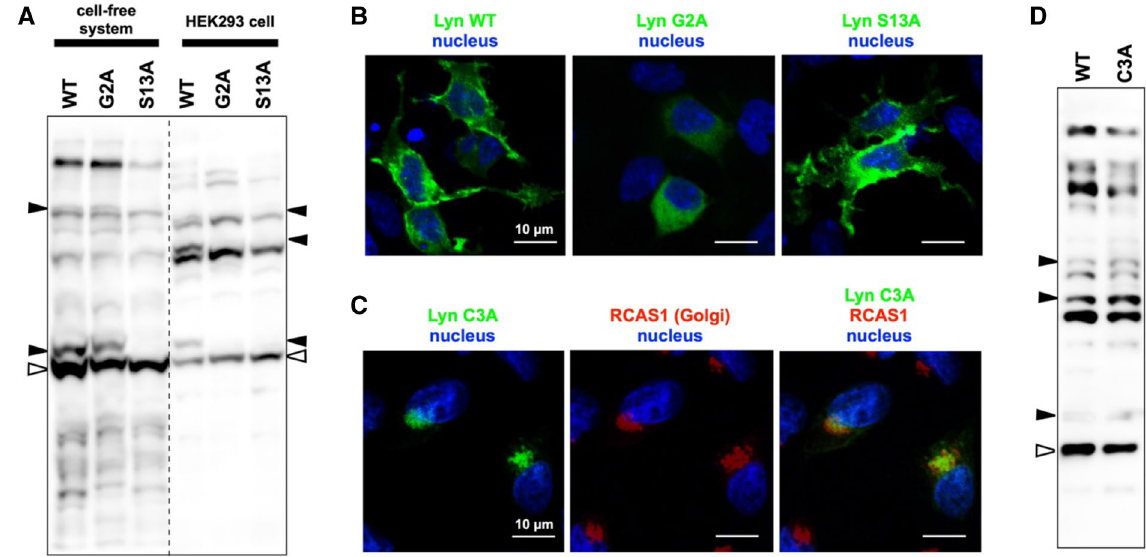
Figure 3. Phos-tag banding image of Lyn synthesized in a cell-free protein-synthesis system, cellular localization of Lyn WT, G2A-, S13A-, and C3A-mutant proteins, and Phos-tag banding image of the WT and C3A-mutant proteins. ( A ) Lyn WT protein, its G2A mutant, and the S13A mutant synthesized by using the TnT T7 Insect Cell Extract Protein Expression System were analyzed by Phos-tag SDS-PAGE (20 μM Zn 2+ –Phos- tag and 7% w/v polyacrylamide). For reference, FLAG-tagged WT and its G2A and S13A mutants expressed in HEK293 cells were analyzed on an identical Phos-tag gel, followed by immunoblotting with a cocktail of anti-Lyn antibody and anti-FLAG antibody. Open arrowheads: nonphosphorylated species; closed arrowhead: phosphospecies containing a phosphorylated Ser-13 residue. The raw image shown in Supplementary Figure S8A has been spliced to arrange the lanes appropriately. The position of the splice is indicated by a vertical dashed line. ( B ) Cellular localization of FLAG-tagged Lyn WT, its G2A mutant, and the S13A mutant expressed in HEK293 cells. The expressed proteins and the nucleus were detected by immunofluorescence staining with anti-FLAG antibody (green) and Hoechst 33342 (blue), respectively. ( C ) Cellular localization of FLAG-tagged C3A mutant expressed in HEK293 cells. The expressed protein, the Golgi, and the nucleus were detected by immunofluorescence staining with anti-FLAG antibody (green), anti-RCAS1 antibody (red), and Hoechst 33342 (blue), respectively. ( D ) Comparison of Phos-tag banding patterns between the WT protein and a C3A mutant of Lyn. FLAG-tagged Lyn WT and its C3A mutant expressed in HEK293 cells were analyzed by Phos-tag SDS-PAGE (20 μM Zn 2+ –Phos-tag and 7% w/v polyacrylamide) followed by immunoblotting with anti-FLAG antibody. Open arrowhead: nonphosphorylated species; closed arrowheads: phosphospecies containing a phosphorylated Ser-13 residue. The raw image is shown in Supplementary Figure